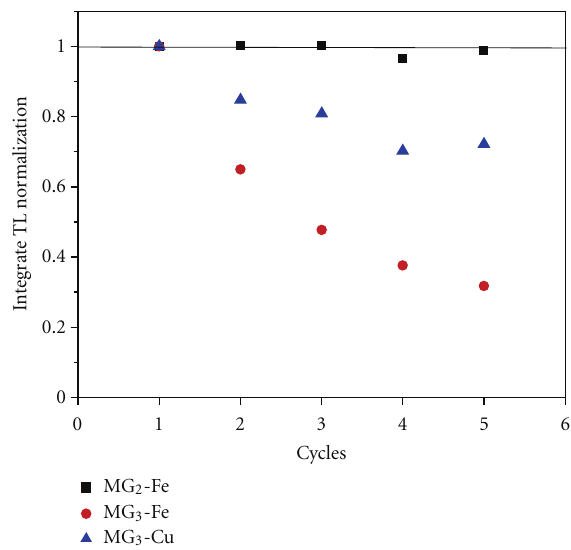
Figure 12: Reproducibility of the TL glow of silica glasses after being expose 5 times to beta particles for 100 Gy dose each.